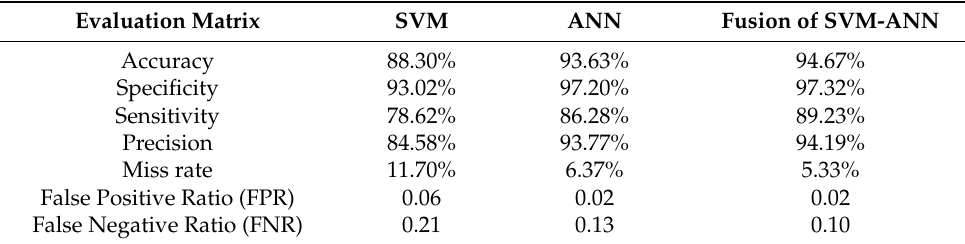
Table 4. Overview of Simulation Results.